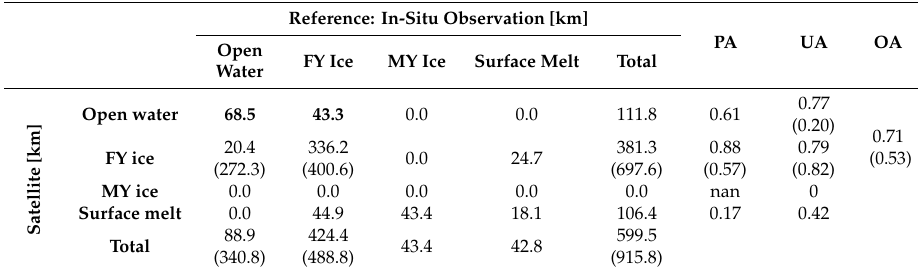
Table 2. Error matrix of comparison between visual observation and the ice classification algorithm. The vertical columns show the ice classification results, while the horizontal rows show the results of visual observation as reference data. The accuracy was verified with the indicators of overall accuracy (OA), producer’s accuracy (PA), and user’s accuracy (UA). The values of PA, OA, and UA represent the ratios of accuracy, and other values represent the distances in km. The values in parentheses are the results including the “ Otone-Suiro ”